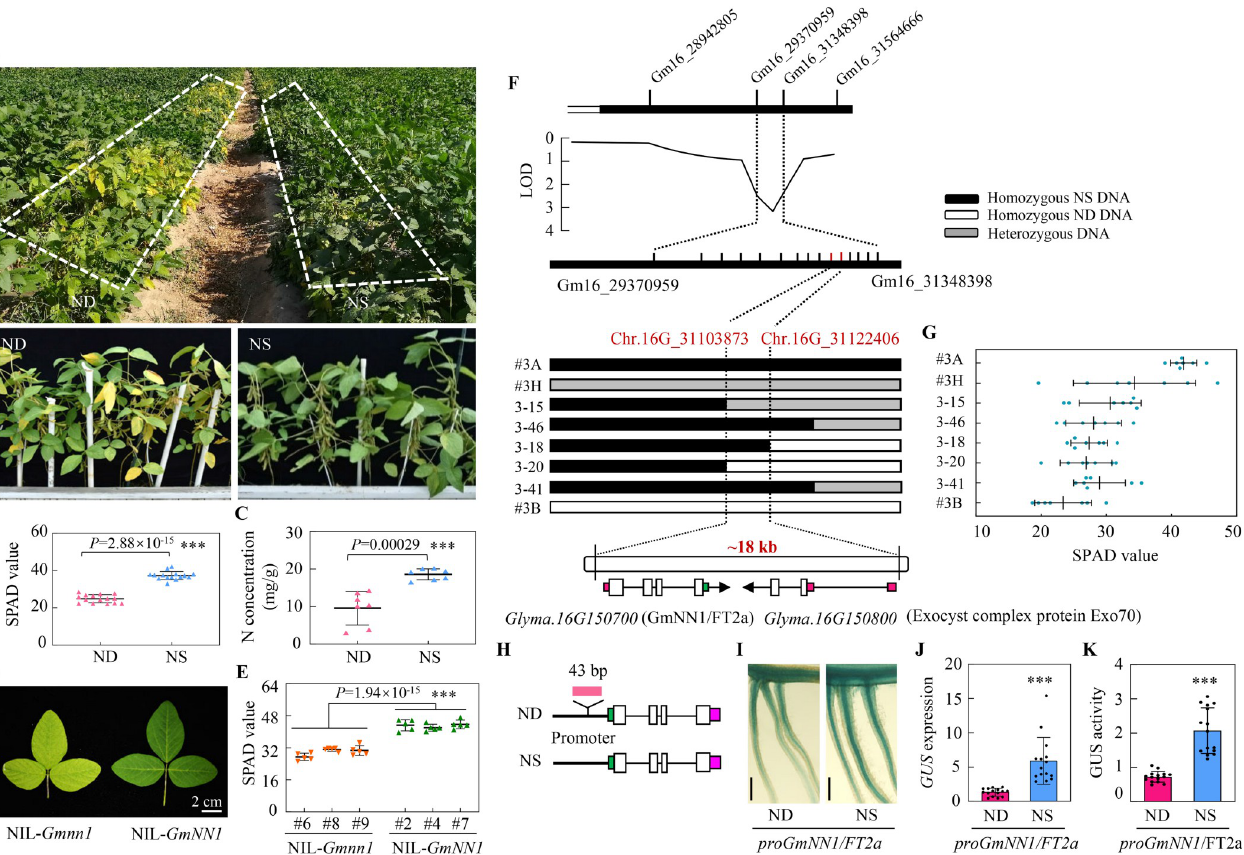
Fig 1. Positional cloning of qNN1 on chromosome 16. AU : AbbreviationlistshavebeencompiledforthoseusedinFigs 1 (cid:0) 6 ; S 1 (cid:0) S 3 ; S 5 (cid:0) S 7 ; S 9 ; S 10 andS 1 Table : Pleaseverifythatallentriesarecorrect : (A) Pictures of ND and NS soybean materials grown in the field . (B) SPAD value ( n = 15). (C) Leaf N concentration ( n = 7). Values are the means from 2 independent experiments. (D) Pictures of new leaves from the NILs of qNN1 . (E) Leaf SPAD value of NILs ( n = 5). Three independent lines of each NIL were generated, and 5 biological replicates for each line were harvested for SPAD value analysis. (F) Map-based cloning of GmNN1 . Fine mapping was performed with sub-F 3:4 populations. The delimited 18-kb genomic region for qNN1 contains 2 predicated genes in the reference genome of Ws82. (G) Putative phenotypes of the recombinant plants were evaluated based on observations of the progeny ( n = 7). (H) Gene structure and allelic variation of GmNN1 between ND and NS. Hollow, green, and red boxes represent exons, 3 0 -UTR and 5 0 -UTR, respectively. Bold and fine lines represent promoter and intron regions, respectively. (I) GUS staining of the soybean transgenic hairy roots harboring the GmNN1 promoter ( proGmNN1 / FT2a ) PCR amplified from either ND or NS plant. Scale bars, 500 μ M. (J) Relative expression of the GUS gene ( n = 15). (K) Quantitative GUS activity measured in fluorimetric assays ( n = 15). All data are given as mean ± SD. Asterisks denote significance of differences (threshold P = 0.05) according to Student t tests; ��� P < 0.001. Data underlying the graphs in the figure can be found in S1 Data. N, nitrogen; ND, N deficient; NIL, near-isogenic line; NS, N